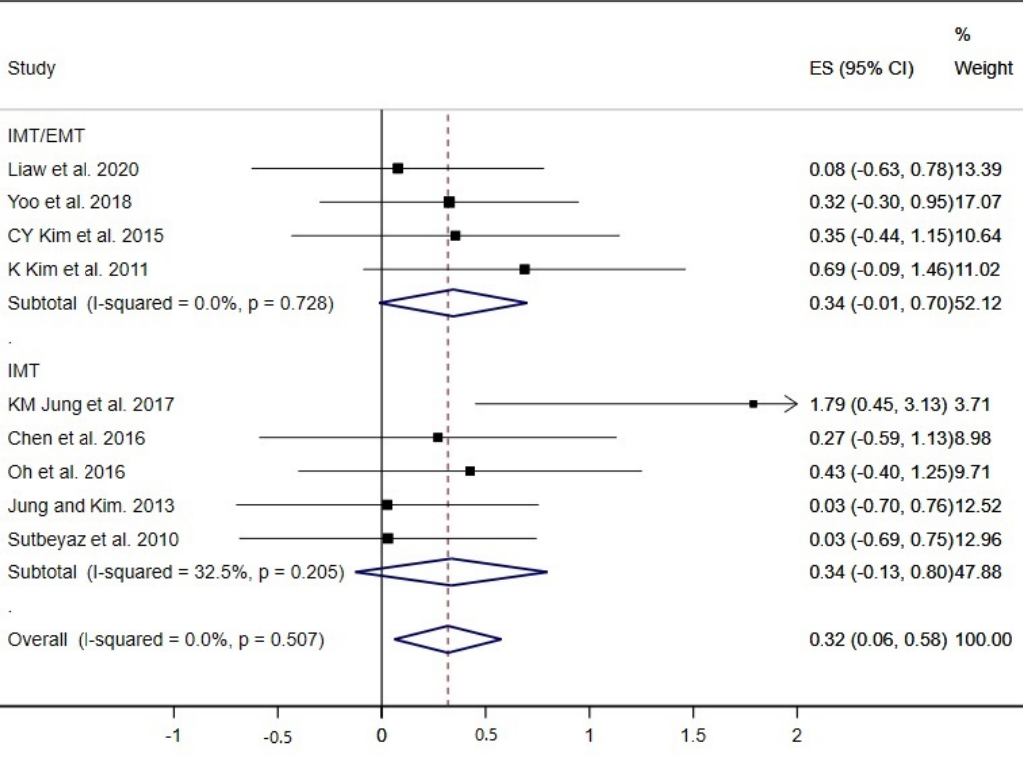
Figure 3. Forest plot showing the e ff ect size (ES) of respiratory muscle training (RMT) on forced vital capacity (FVC) between intervention and control groups for each study. IMT, inspiratory muscle training; EMT, expiratory muscle